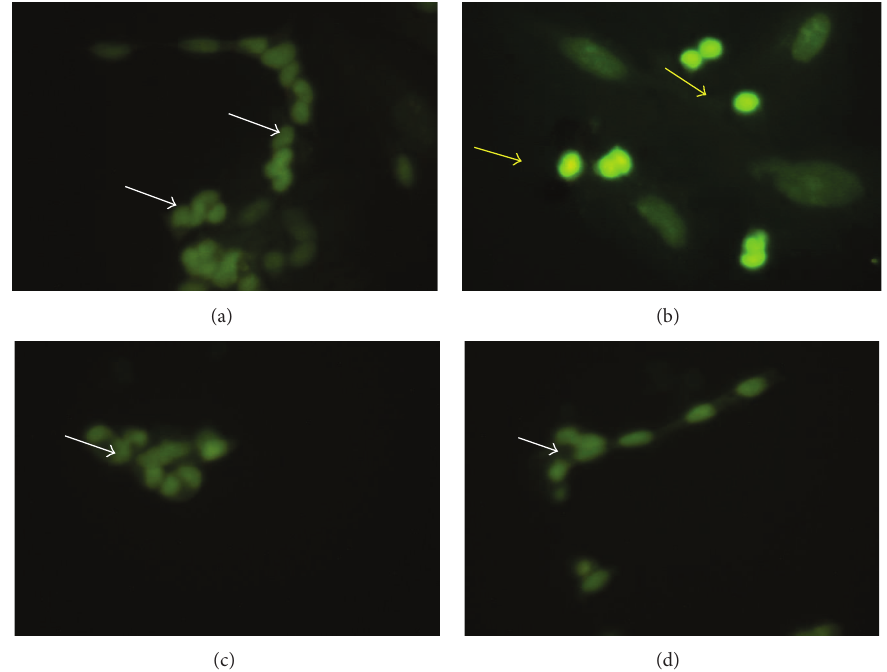
Figure 2: AO/EB staining in differentiated SH-SY5Y cells after treatment. (a) Control, (b) glutamate (20 mM), (c) glutamate (20mM) + insulin (0.1 𝜇 M), and (d) glutamate (20 mM) + insulin (1 𝜇 M). White arrow: live cell; yellow arrow: apoptotic